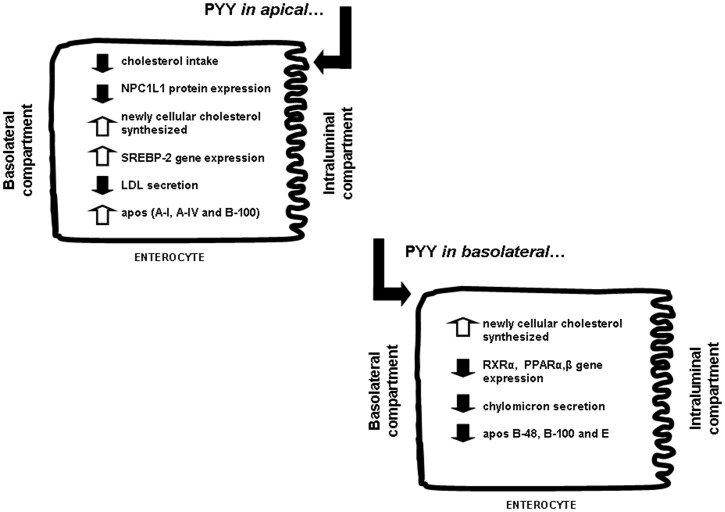
Integrative scheme documenting the asymmetrical regulation of lipid transport by apical and basolateral PYY stimuli using differentiated, polarized Caco-2/15 cells.